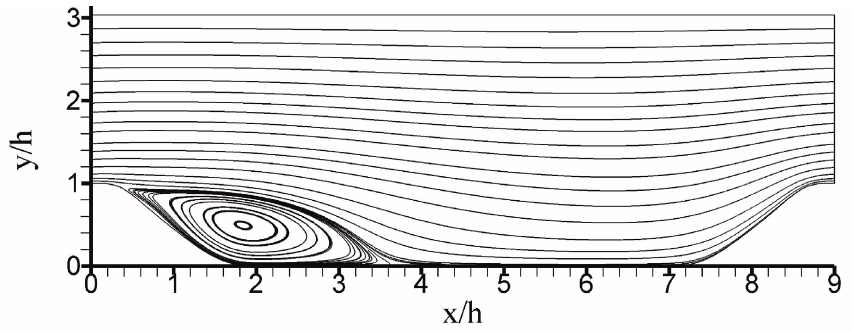
Figure 4. Periodic hill flow velocity streamlines obtained by CES at Re = 37,000 on G 500 ( G 500 refers to 500,000 grid points). Reprinted with permission from [27]. Copyright 2020 AIP